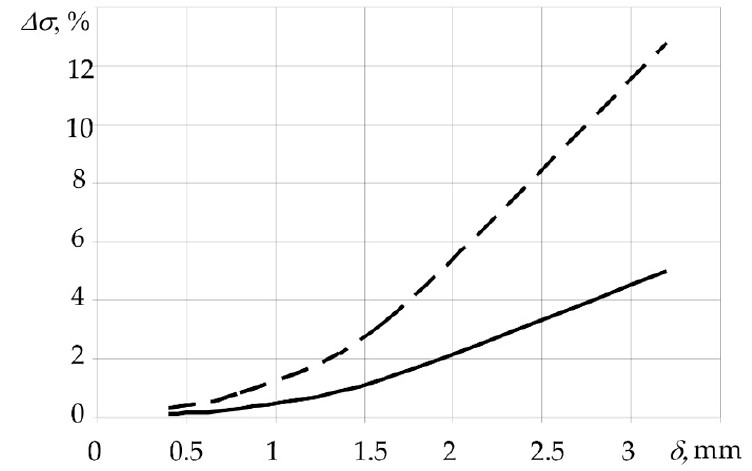
Figure 9. Change in maximum stresses calculated considering the rate of temperature change ( ν p ) and thickness of moulded package: ––– ν p = 2 °C/min; – – ν p = 5 °C/min To obtain thin-walled structures with high accuracy or contours, it is unacceptable to neglect the unevenness of the temperature field across the thickness because of deflections, which occur after removal of the product from the shaping surface. For the laminated structures under study, deflections at the rate of temperature change of more than 1–2 °C/min were not acceptable, since the allowable deflection should not exceed 1– 2 mm, and for high-precision dimensionally stable structures the allowable deflection should be a maximum of 0.1 mm [2,34]. 6. Conclusions and Further Research A new method for determining the SSB depending on heating conditions and the distribution of the temperature field over the thickness of a moulded PCM package has been developed. The method establishes the relationship between moulding process parameters and the effect of the auxiliary equipment and shaping surface on the distribution of the temperature field and the SSB in the moulded product. The rate of temperature change at the stage of heating has its effect on the amount of residual deformation of the structure. As shown by the experimental data, specimens moulded under conditions of an increased heating rate featured higher deflection than those moulded at a lower heating rate. The error of results obtained during the numerical experiment based on the models and results of the full-scale experiment did not exceed 6.8%. Our results enable the calculation of the residual SSB of a moulded structure with the required degree of accuracy without a series of experiments and, accordingly, significantly simplify the practical implementation of the developed method and avoid any additional production costs. The proposed calculation pattern describes the SSB occurring in smooth panel structures, however, replacing the mathematical model for calculating the plate by another pattern for a beam, rod, or skin, will allow us, in the future, to calculate the SSB in the moulding process, considering the uneven distribution of temperature over the product thickness. It is necessary to note that calculations of the residual SSB in asymmetric structures should consider the difference between the initial and final temperatures of the moulding process, in addition to the temperature differential across the thickness of the PCM package.